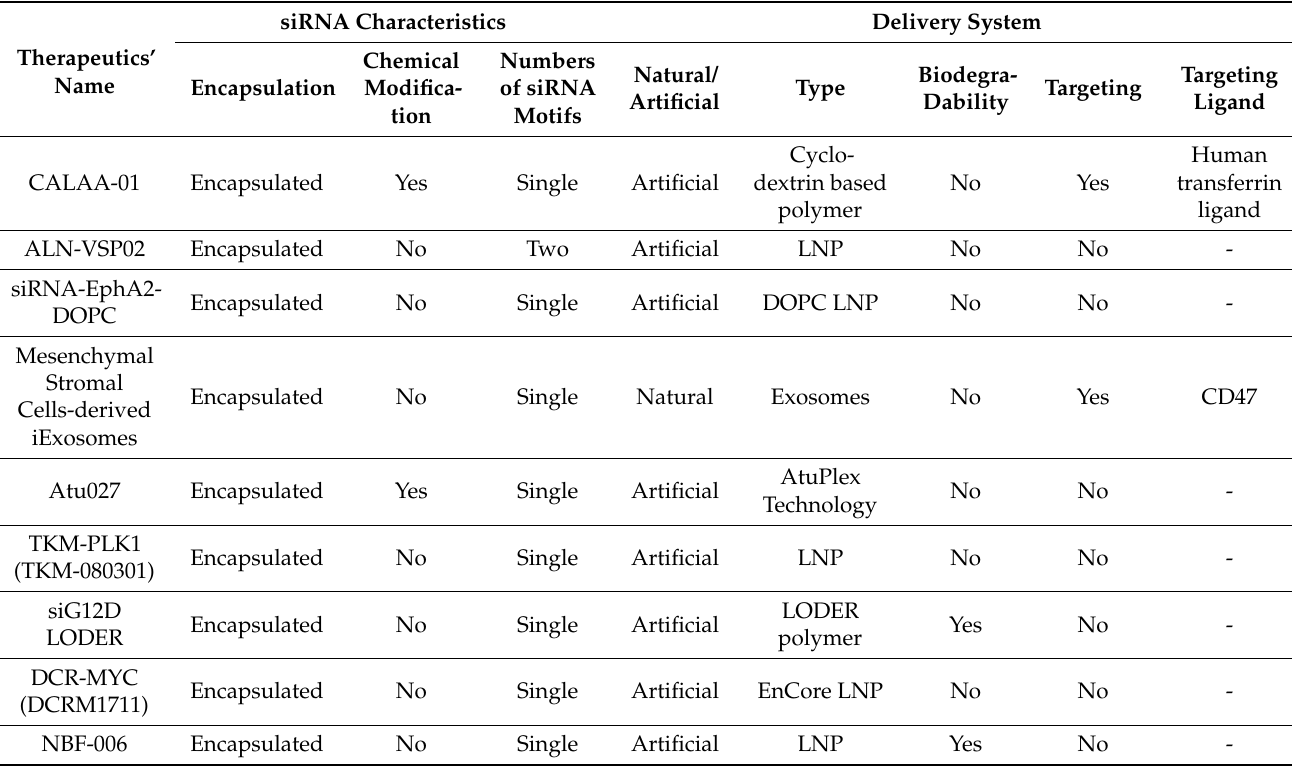
Table 2. Characteristics of siRNA motifs and delivery nanoplatforms within RNAi mediated anticancer nanotherapeutics.